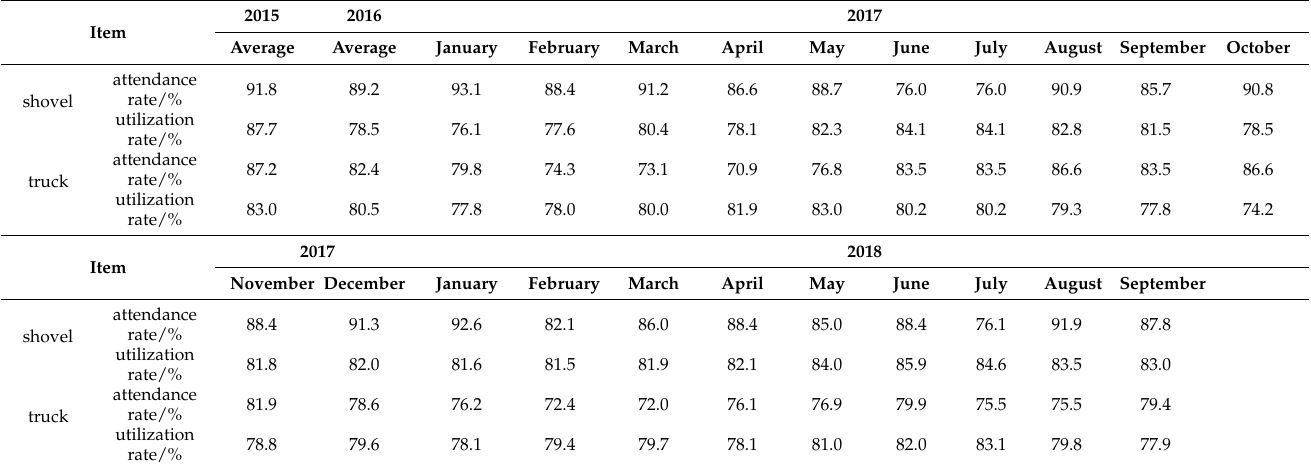
Table 1. Attendance rate and utilization rate of truck-shovel equipment in Toromocho Copper